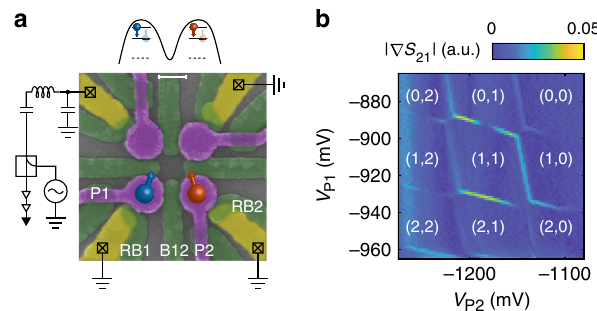
Fig. 1 Fabrication and operation of a planar germanium double quantum dot. a False-coloured scanning electron microscope image of the quadruple quantum dot device. Ohmic contacts are indicated in yellow, a fi rst layer of electrostatic barrier gates is indicated in green and the second layer of plunger gates is coloured in purple (for details, see Methods). The scale bar corresponds to 100 nm. We use the double quantum dot in the top channel as a single-hole transistor (SHT) to sense changes in the charge occupation of the quantum dots formed under plunger gates P1 and P2. A schematic illustration of the electrostatic potential de fi ning the two single-hole quan- tum dots is depicted above the fi gure. The charge sensor impedance is measured using re fl ectometry on a resonant circuit consisting of a super- conducting resonator and the parasitic device capacitance. Barrier gates RB1 and RB2 can be used to control the tunnel rate of each quantum dot to its respective reservoir and gate B12 controls the interdot tunnel coupling. b Charge stability diagram of the double quantum dot system, where depletion of both quantum dots up to the last hole can be